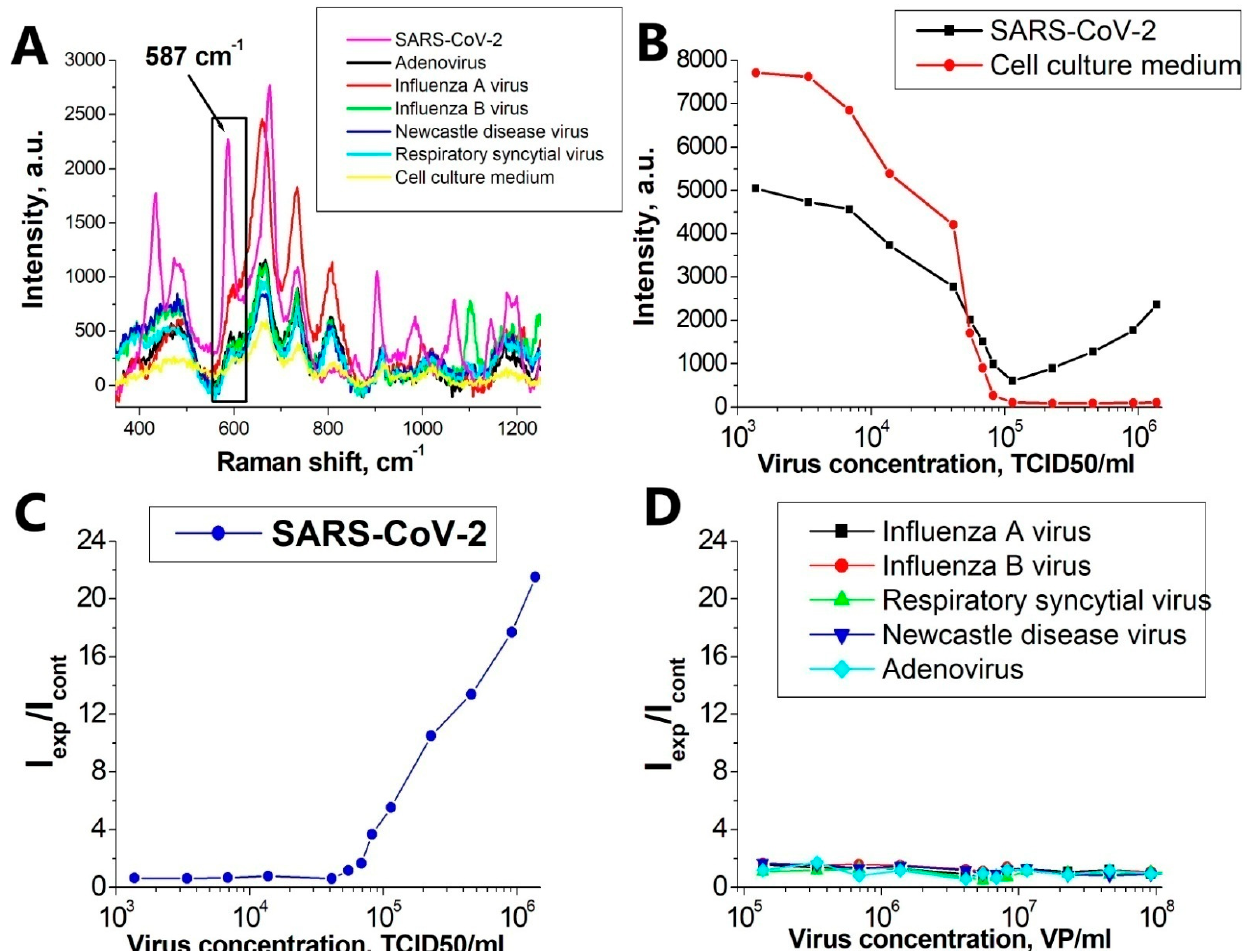
Figure 4. Detection of SARS-CoV-2. ( A ) SERS spectra of an experimental virus sample (SARS-CoV-2) at a concentration of 4.6 × 10 5 TCID50/mL; virus-free cell culture medium in the same dilutions and control viruses in the same concentrations. ( B ) The dependence of the peak intensity of 587 cm − 1 on the concentration of SARS-CoV-2 and for the virus-free cell culture medium in the same dilutions. ( C ) Concentration curve for SARS-CoV-2. ( D ) Concentration curve for control viruses.